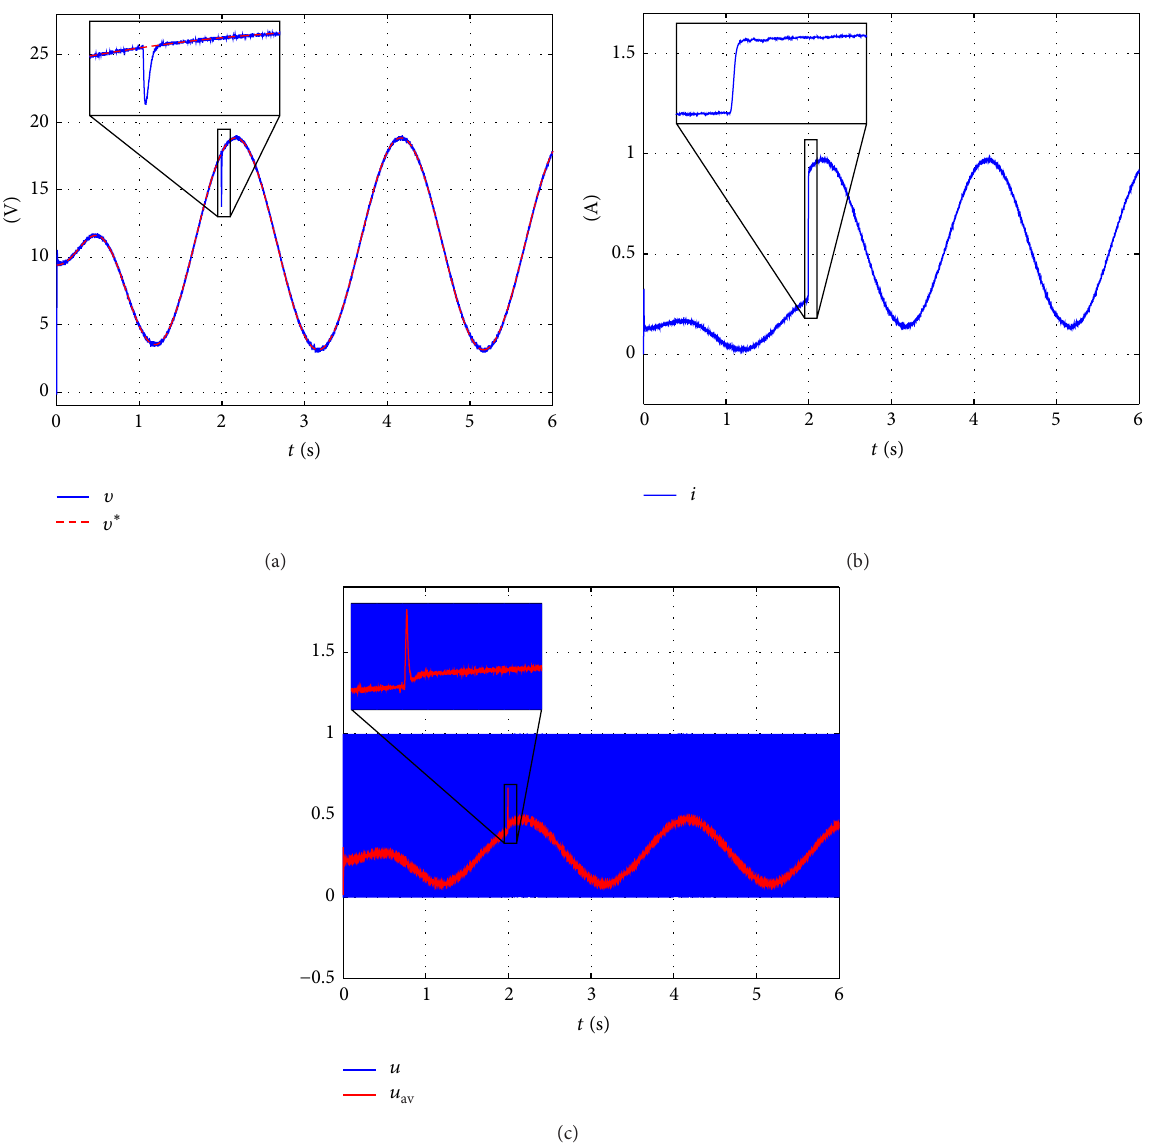
Figure 8: Case (ii) via Σ - Δ